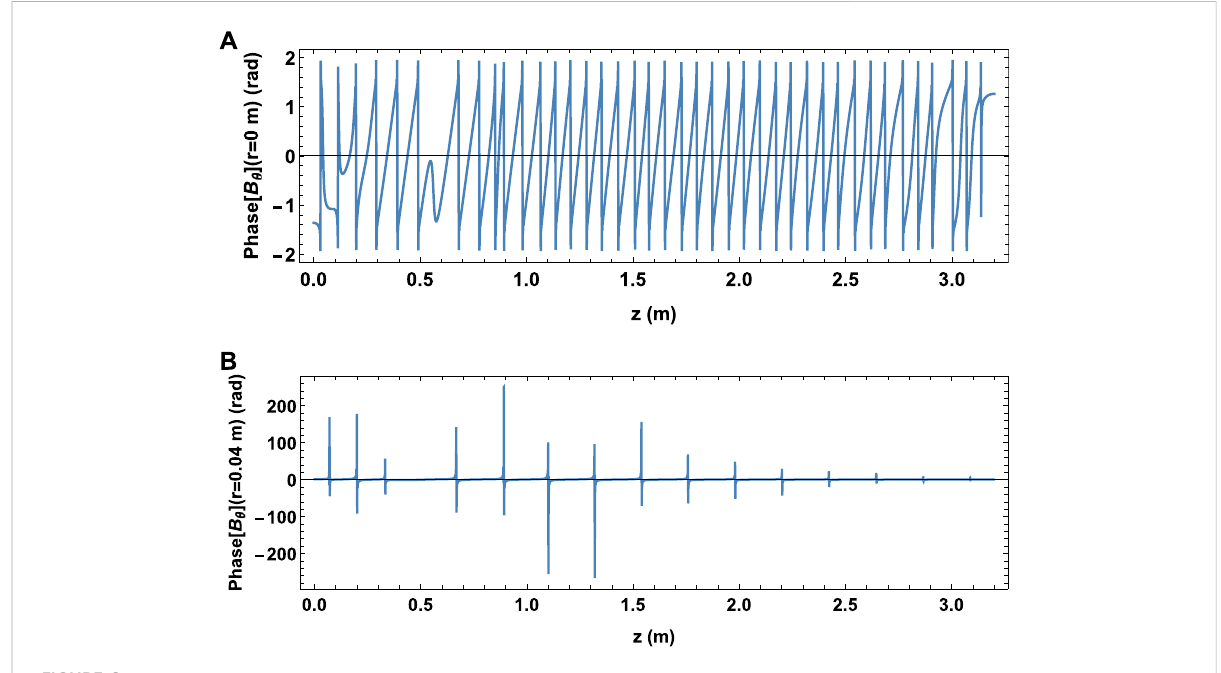
FIGURE 6 Phase for wave magnetic fi eld inside (A) , ( r = 0 m) and outside (B) , ( r = 0.04 m) blue-core column ( B 0 = 0.16